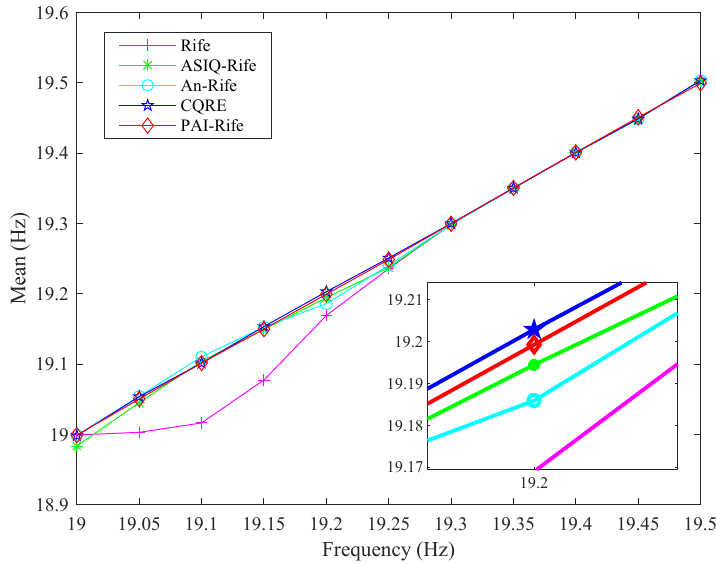
Figure 2. Mean of PAI − Rife and other Rife algorithms at different frequencies.